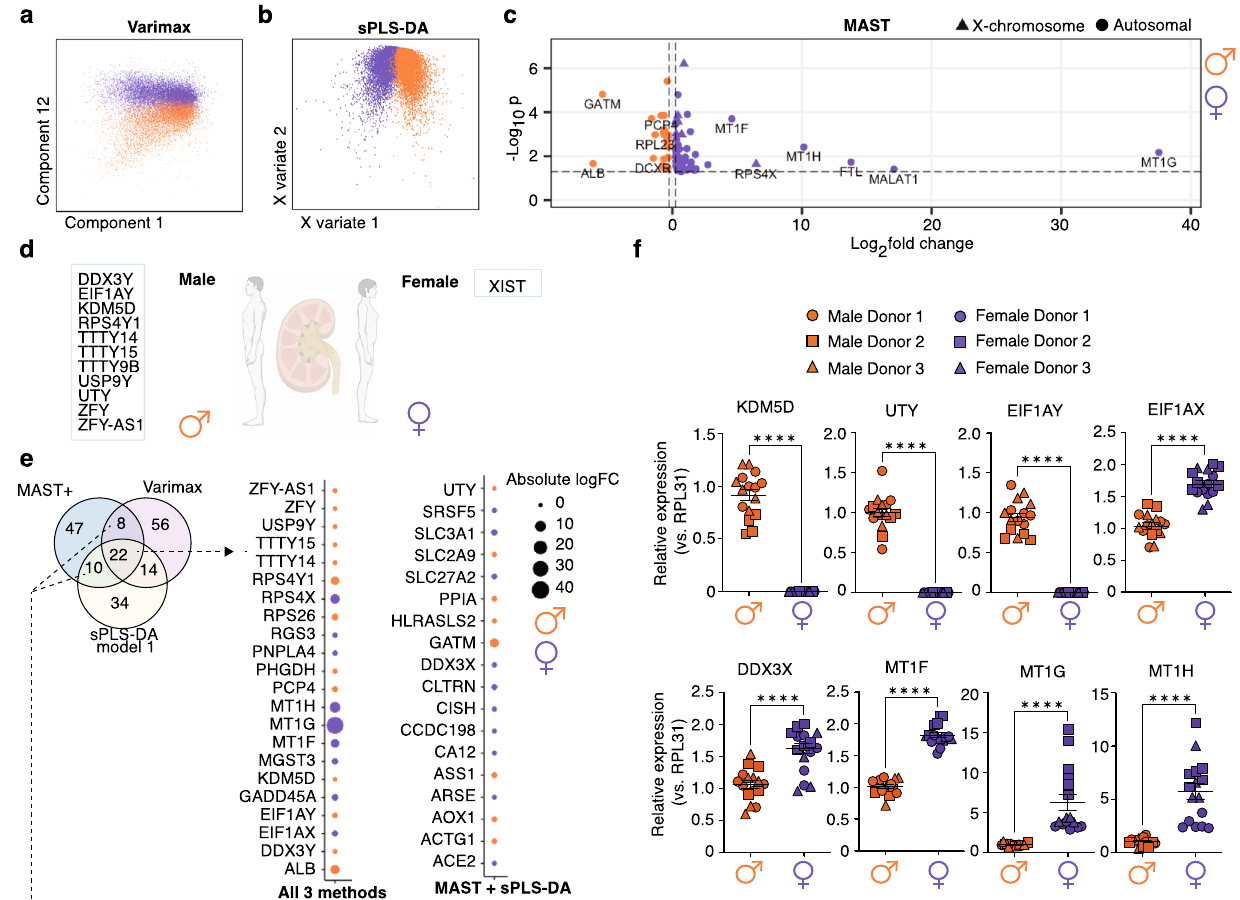
Fig. 2 | Identifying genes differentially expressed between male and female proximal tubular cells. 2-Dimensional plots of ( a ) Varimax-rotated PCA and ( b ) sPLS-DAshowingseparationofmaleandfemalecells,and( c )volcanoplotshowing differential expression of genes between sexes from MAST analysis with sample randomeffect. d Genesexpressedexclusivelybyallsamplesofonesexandnoneof the opposite sex, which were added to the MAST results for comparison across methodsin e (termedMAST+). e Venndiagramdepictinggenesidenti fi edthrough each analysis, with bubble plots highlighting genes identi fi ed by all three methods or by MAST plus one additional method. The size of the circle is proportional to absolute logFC and the colour indicates whether the gene was higher in male (orange) or female (dark purple) PT cells. Source data are provided in Supple- mentary Data 1. f Differences in gene expression of KDM5D ( p <0.0001, t =17.32,